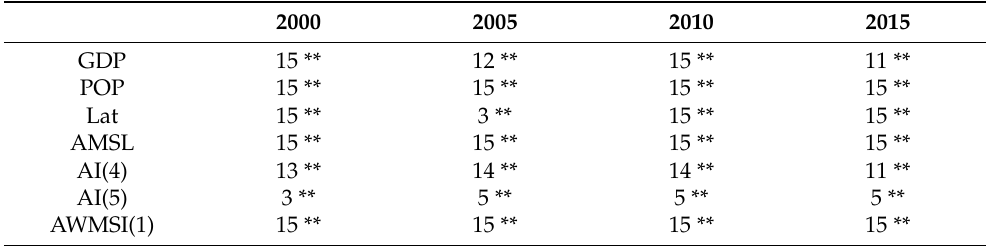
Table A1. The optimal number of categories for discretization of the influence factors of the annual UTCI mean for each year (** represents p < 0.01, * represents p < 0.05; 1: cultivated land; 2: green space; 3: water bodies; 4. construction land; 5: unused